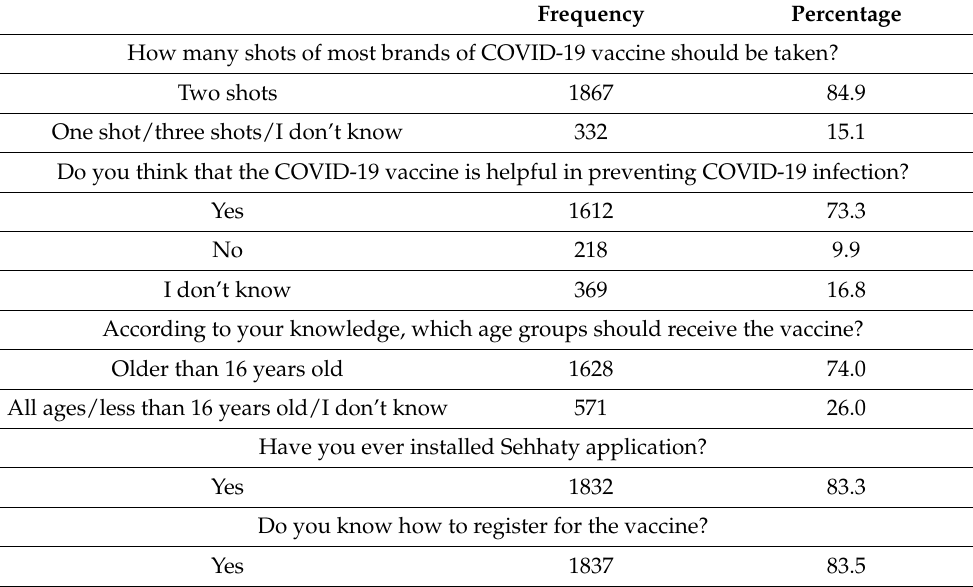
Table 2. The participants’ extent of knowledge of, and attitude towards the vaccine. Frequency